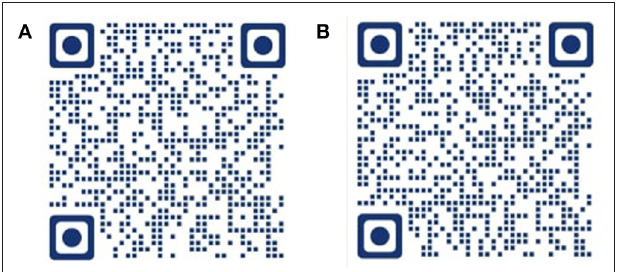
FIGURE 3 | Access videos using the following QR codes. (A) access video 1, (B) access video 2.